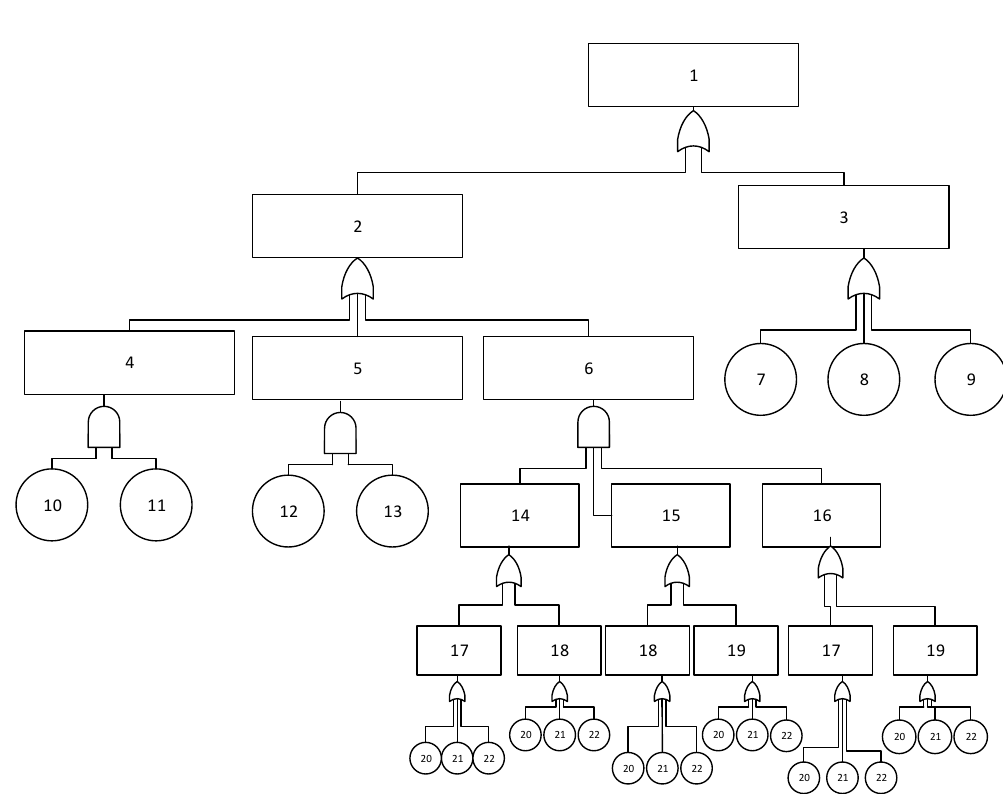
Figure A6. Fault tree of primary system isolation failure. Note: 1 = primary system isolation fail. 2 = valve fails to close automatically. 3 = valve fails to close manually. 4 = in line isolation valve fail. 5 = out